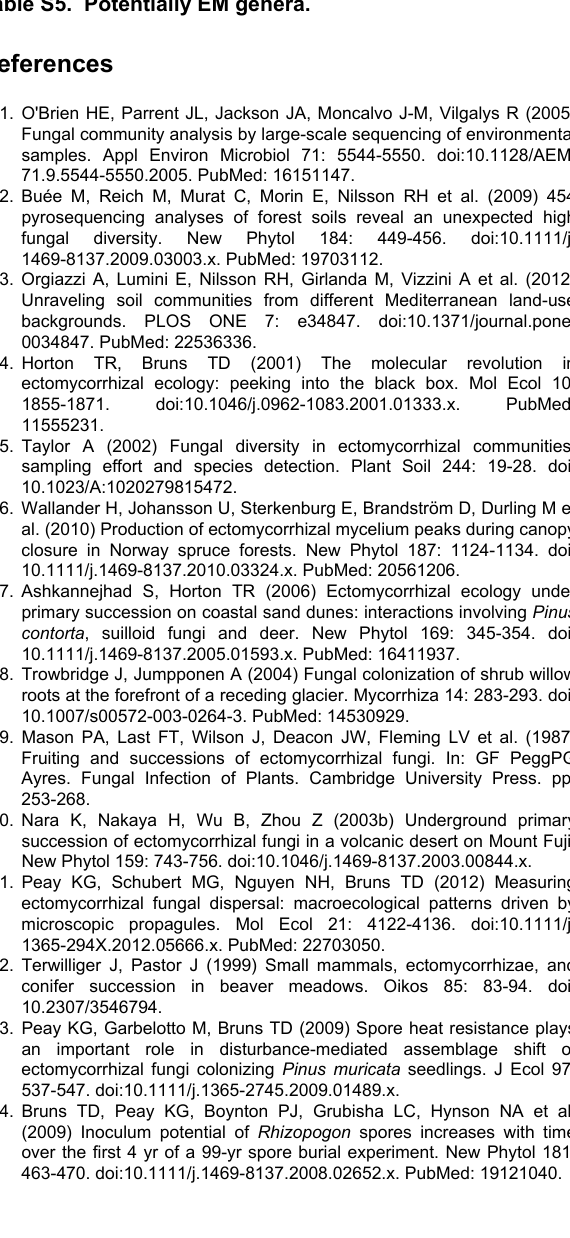
Tables S4. EM genera.